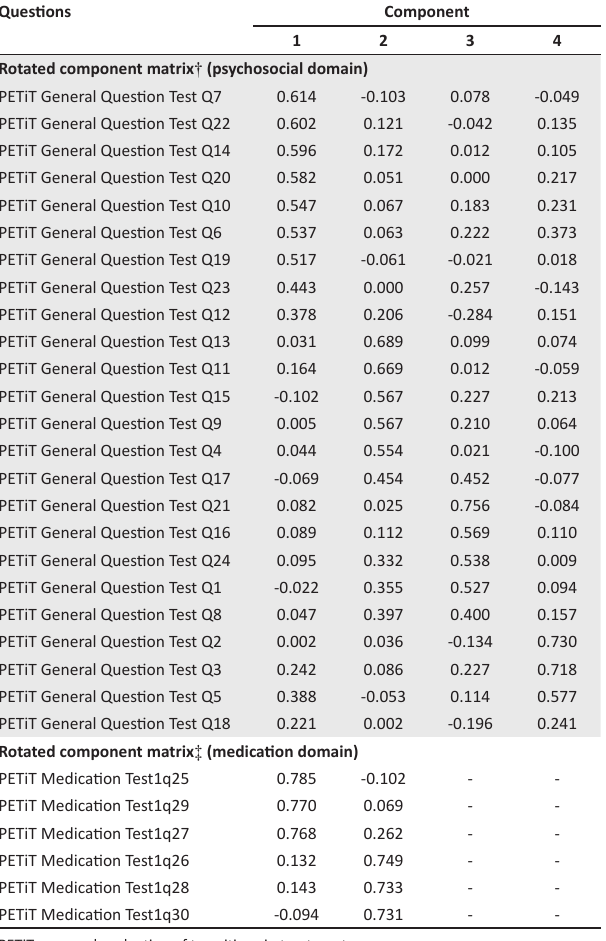
TABLE 4: Rotated component matrix of 30-item personal evaluation of transitions in